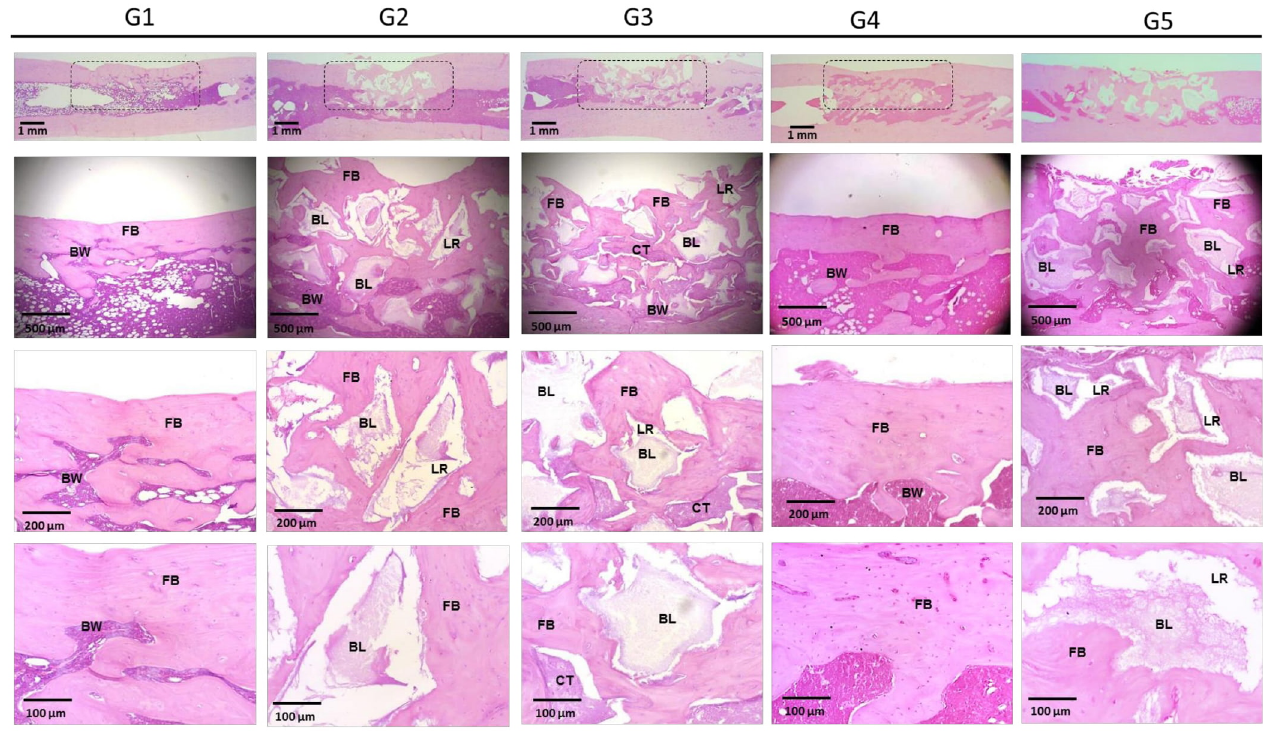
Figure 11. Representative images of histological sections stained with hematoxylin and eosin from the region of interest at 60 days after surgical procedure. LB: adjacent lamellar bone; FB: newly formed bone; BL: calcium phosphate biomaterial; RL: resorption lacunae; BW: bone marrow; CT: cellularized connective